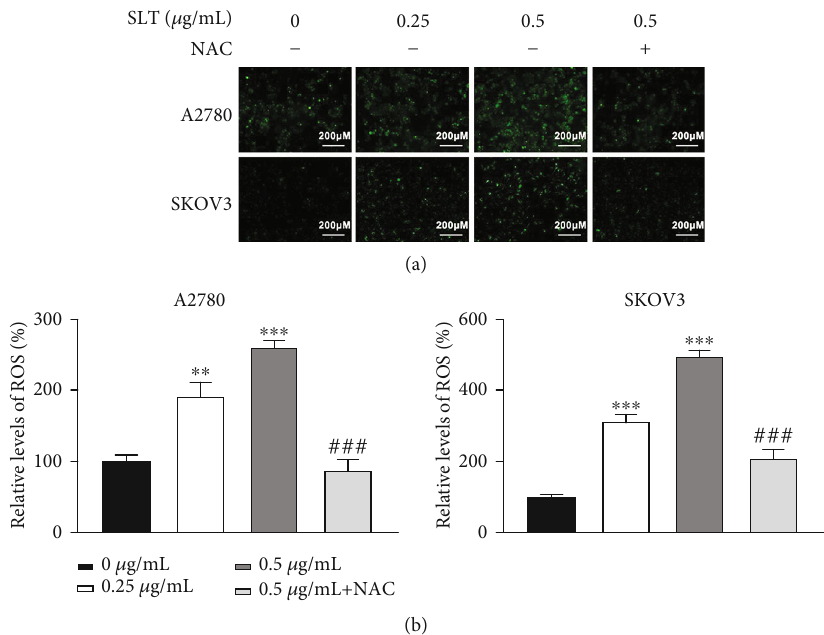
Figure 5: The e ff ects of SLT on ROS production in ovarian cancer cells. (a) The e ff ects of SLT on ROS levels of A2780 and SKOV3 cells were determined using DCF fl uorescence by a fl uorescence microscope (magni fi cation × 100; scale bar = 40 μ m ). (b) The DCF fl uorescence intensity in A2780 and SKOV3 cells a ff ected by SLT was measured by a fl uorescence spectrophotometer. The values were displayed as the mean ± SD . Representative results from three independent experiments were shown ( ∗∗ P < 0 : 01 and ∗∗∗ P < 0 : 001 , compared with the control group; ### P < 0 : 001 , compared with the 0.5 μ g/mL SLT